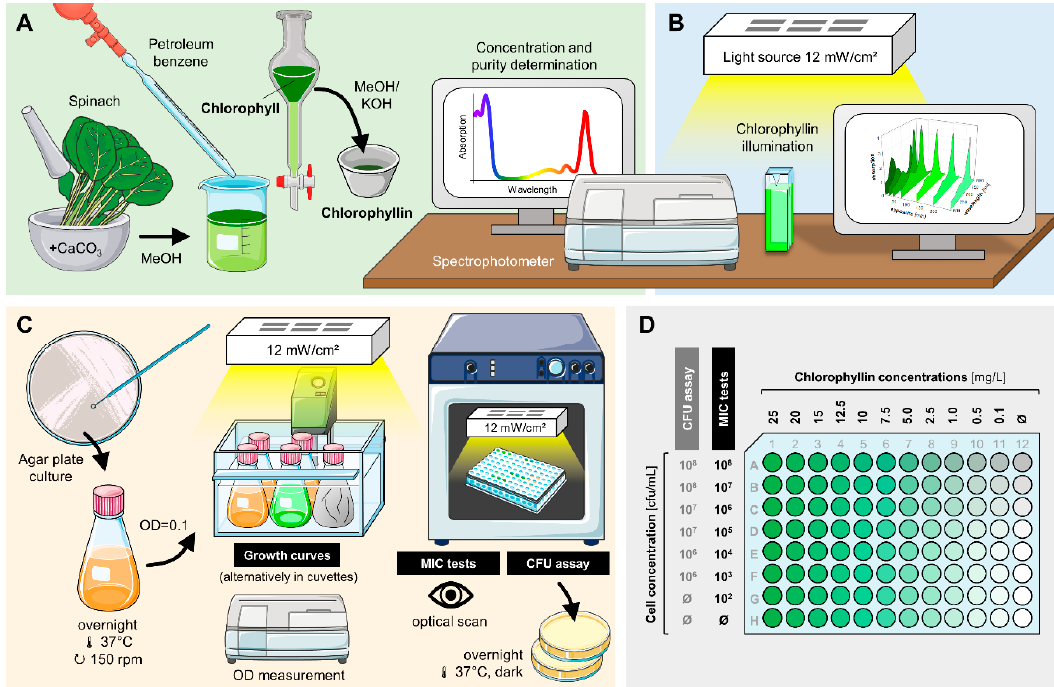
Figure 2. Overview of experimental procedures. ( A ) Chlorophyllin extraction from spinach. ( B ) Determination of chlorophyllin stability in light. ( C ) Experimental setup to test the effects of chlorophyllin on the growth and viability of different bacteria. ( D ) 96-well matrix plate layout for Colony-forming units (CFU) assays and the determination of minimum inhibitory chlorophyllin concentrations (MIC test). The final volume of each well was 200 µ L. After inoculation, the plate